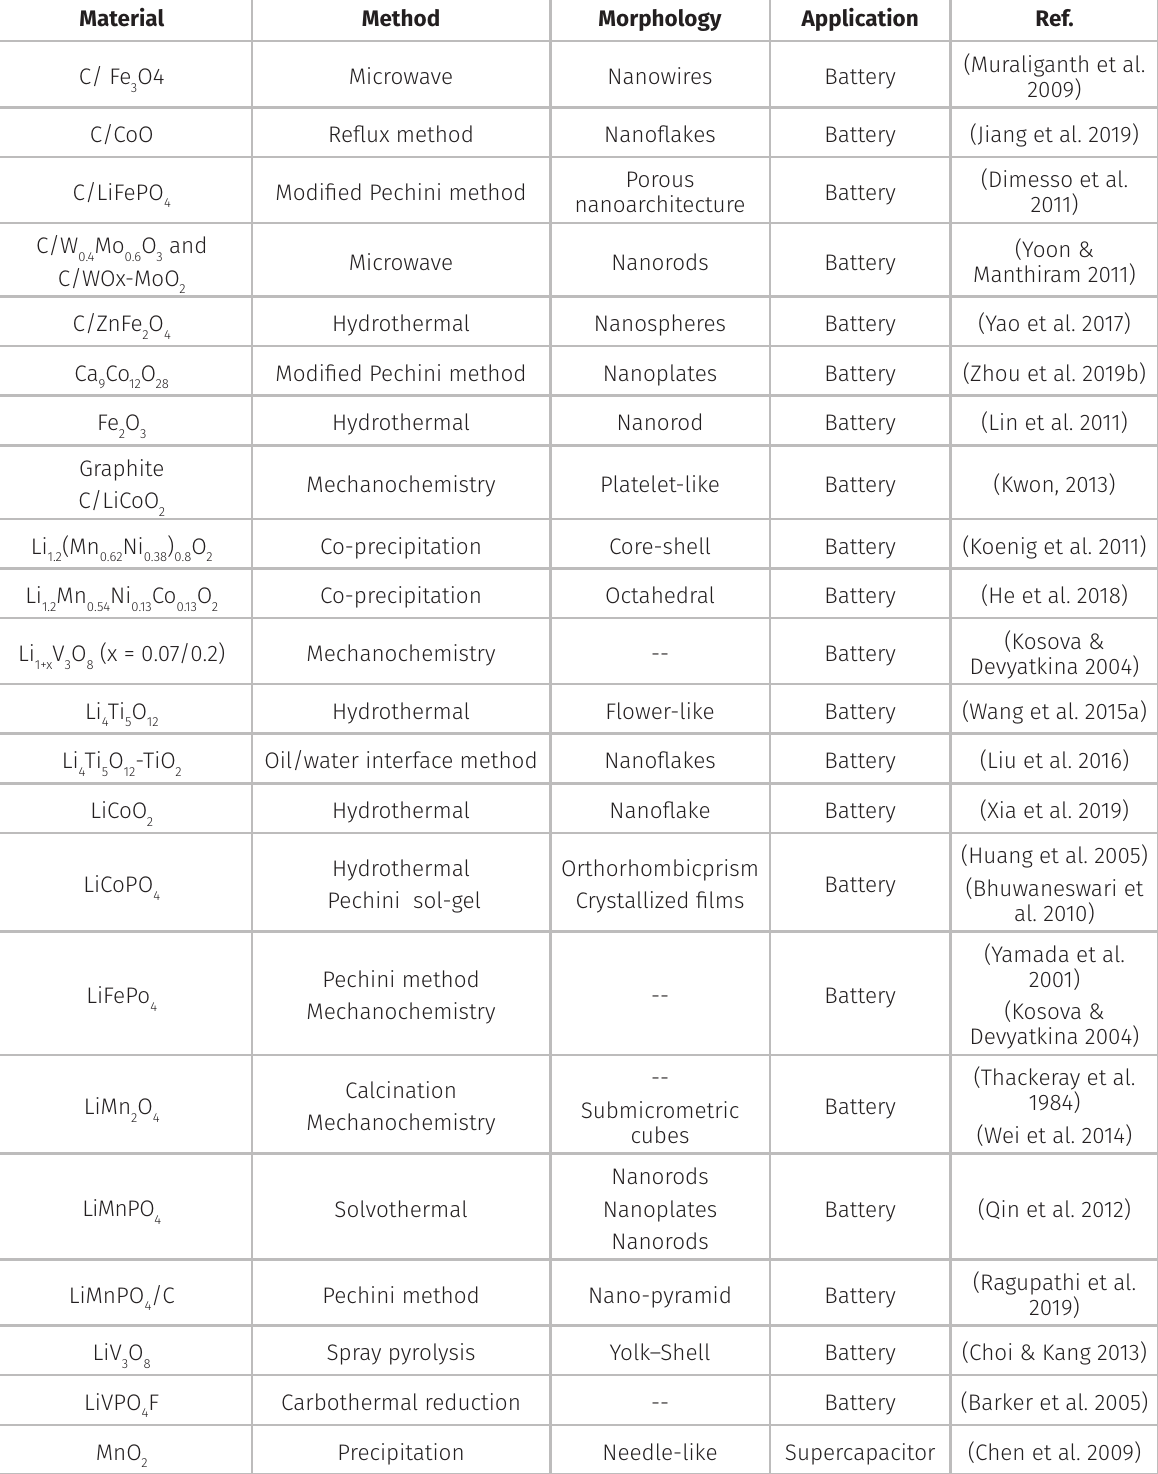
Table I. Materials for electrochemical energy storage devices prepared by different methods with different